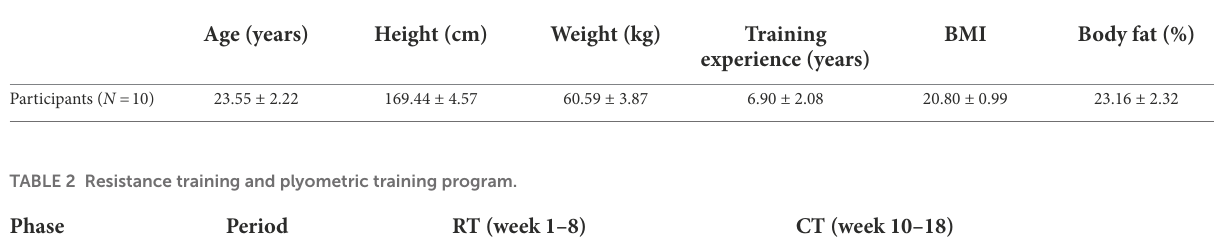
TABLE 1 The demographic information of the participants.